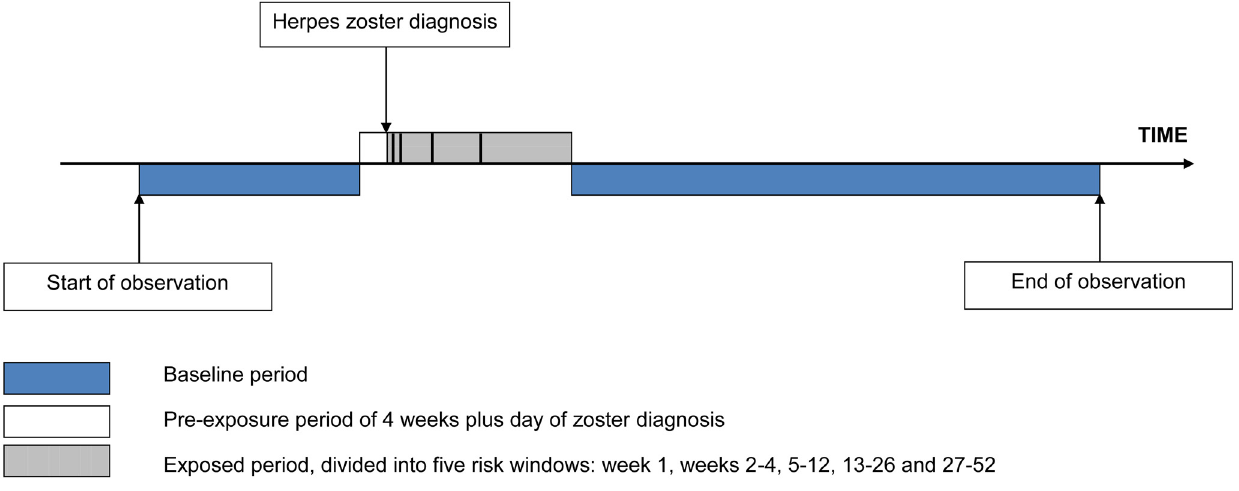
Fig 1. Pictorial representation of the self-controlled case series design, showing the observation period for a single individual.